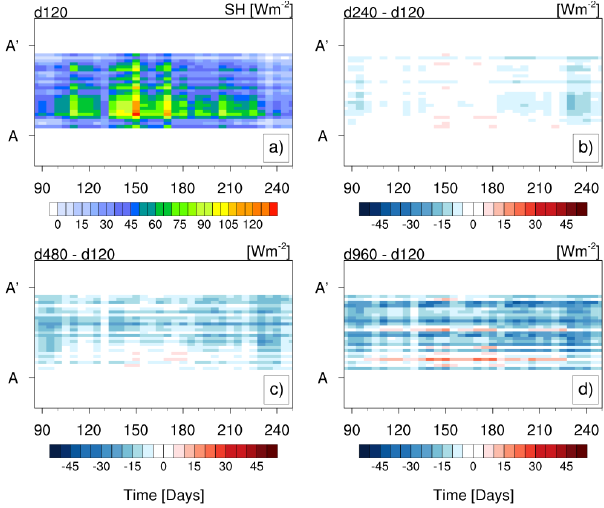
Figure 8. (a) Time evolution of 5-day mean sensible heat flux (SH) along cross-section AA (cid:48) for the d120 domain. (b) Difference in the time evolution of SH between the d240 and d120. (c) Difference in the time evolution of SH between the d480 and d120. (d) Difference in the time evolution of SH between the d960 and d120. For d120, d240 and d480, the SH fluxes were spatially aggregated to 960m resolution.